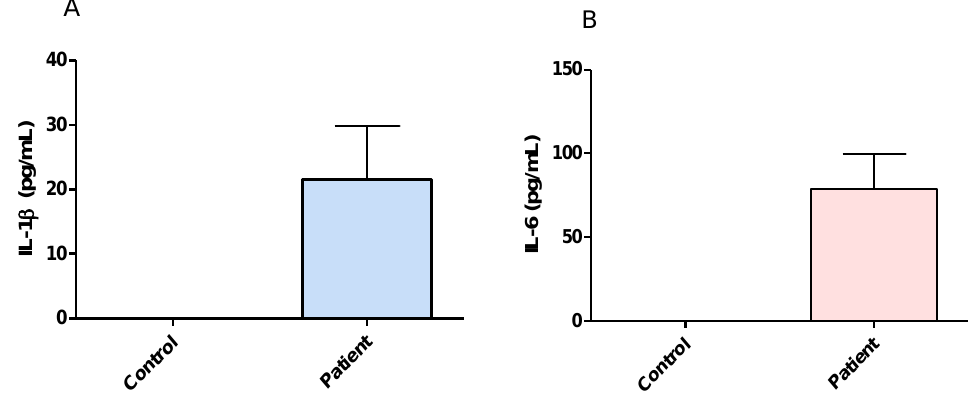
Figure 3. Concentrations of IL-1 β and IL-6 in neocortical tissue from patients with drug-resistant temporal lobe epilepsy and control tissue. ( A ) Concentrations of IL-1 β . ( B ) Concentrations of IL-6. The bars represent the mean ± the standard error of the